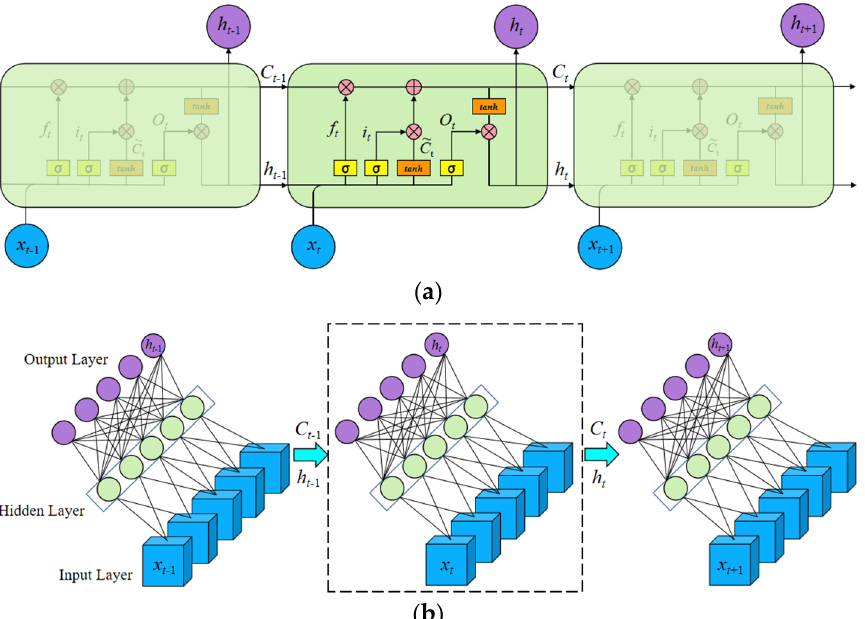
Figure 2. Network structure of LSTM: ( a ) Unit structure of LSTM; ( b ) Recurrent structure of LSTM. Table 1. Advantages and limitations of RNN and LSTM.